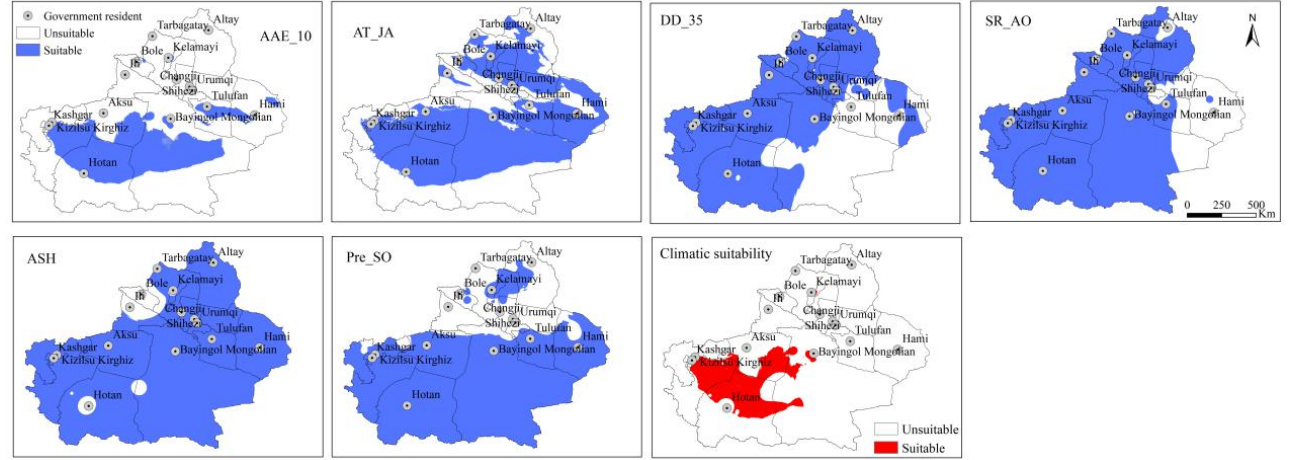
Figure 6. Suitable climate area for long staple cotton seed production, AAE_10, the active accumulated temperature equal to or greater than 10 °C; AT_JA, the average temperature in July and August; DD_35, the duration in days of temperature equal to or greater than 35 ℃ ; SR_AO, the sunshine rate from April to October; ASH, annual sunshine hours; Pre_SO, precipitation from September to October.